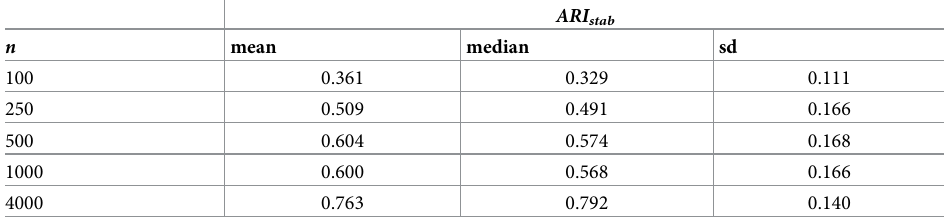
Table 3. Mean, median, and standard deviation of ARI stab , i.e., the ARI between the clusterings of bacterial genera on discovery and validation data, over 50 samplings of discovery/validation data. ARI stab